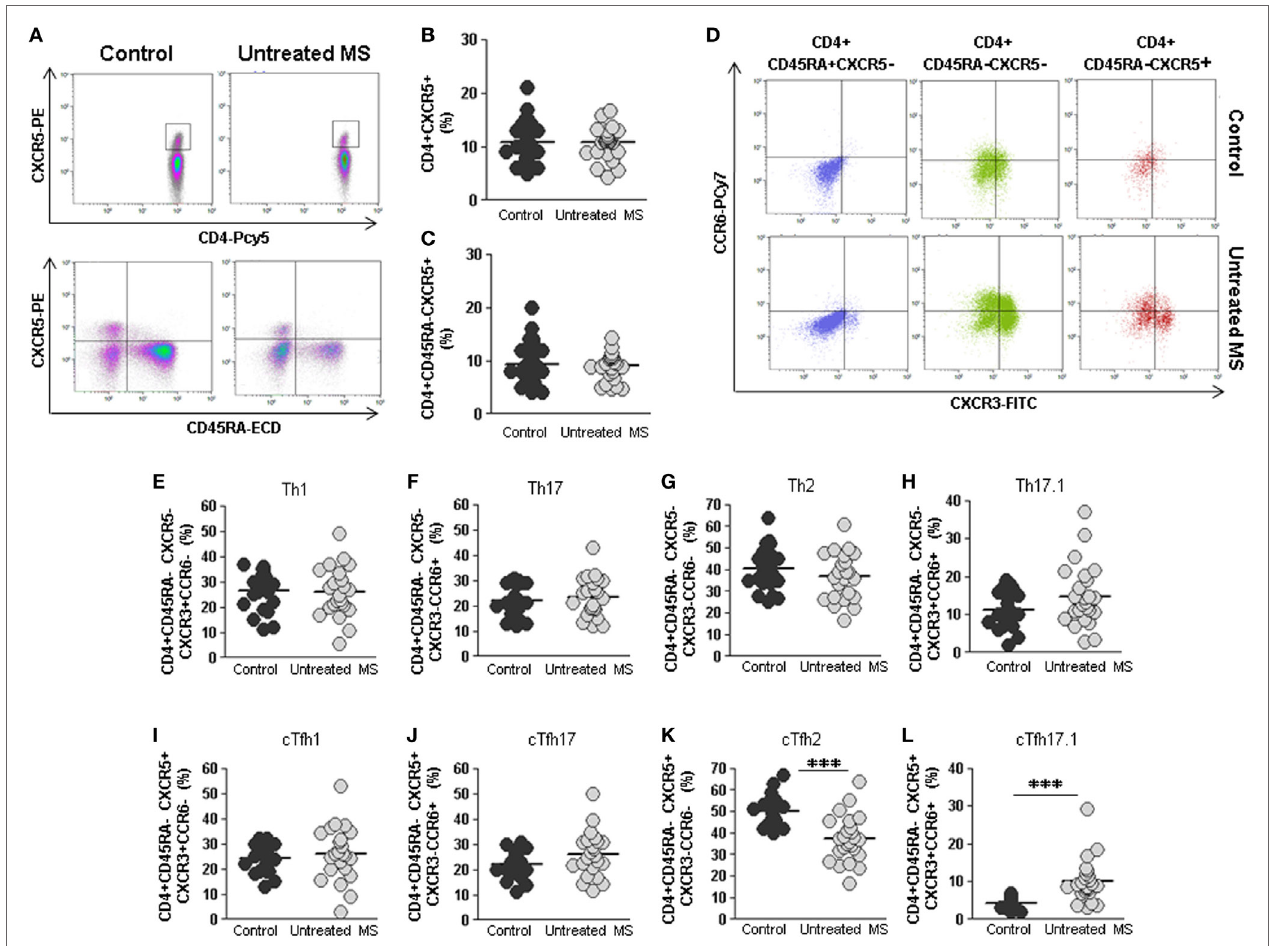
FigUre 2 | Total cTfh cells and subpopulations of Th and cTfh cells from untreated multiple sclerosis (MS) patients. (a) Density plots of the percentage of total follicular